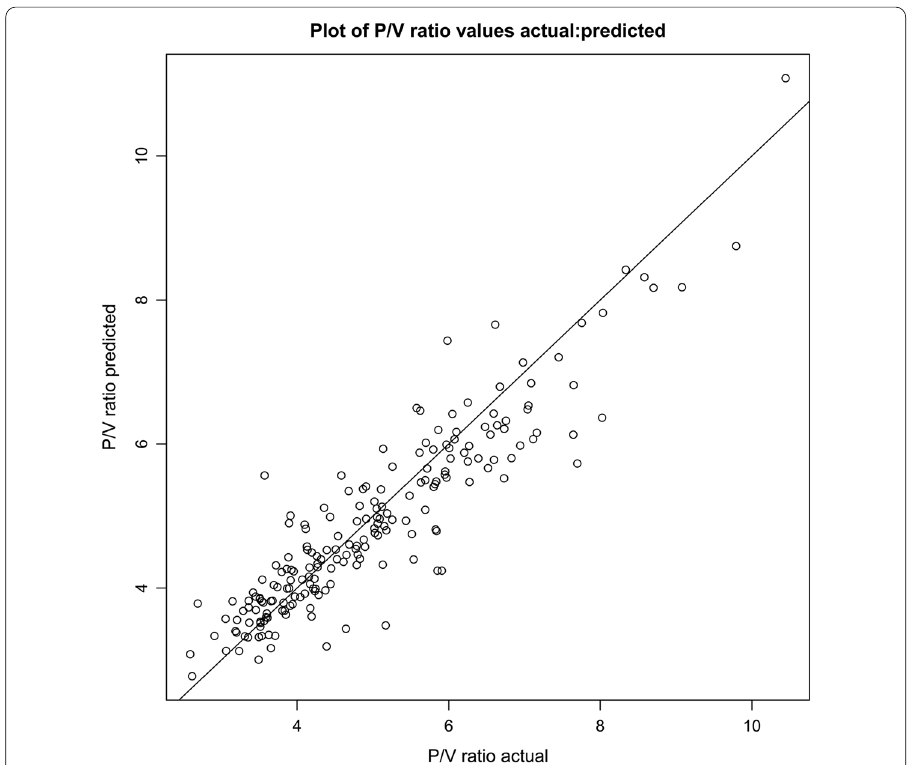
Fig. 3 Scatter plot of P / V ratio values predicted with the Excel-based tool versus actual values (validation dataset). The straight line indicates points for which P / V ratio predicted